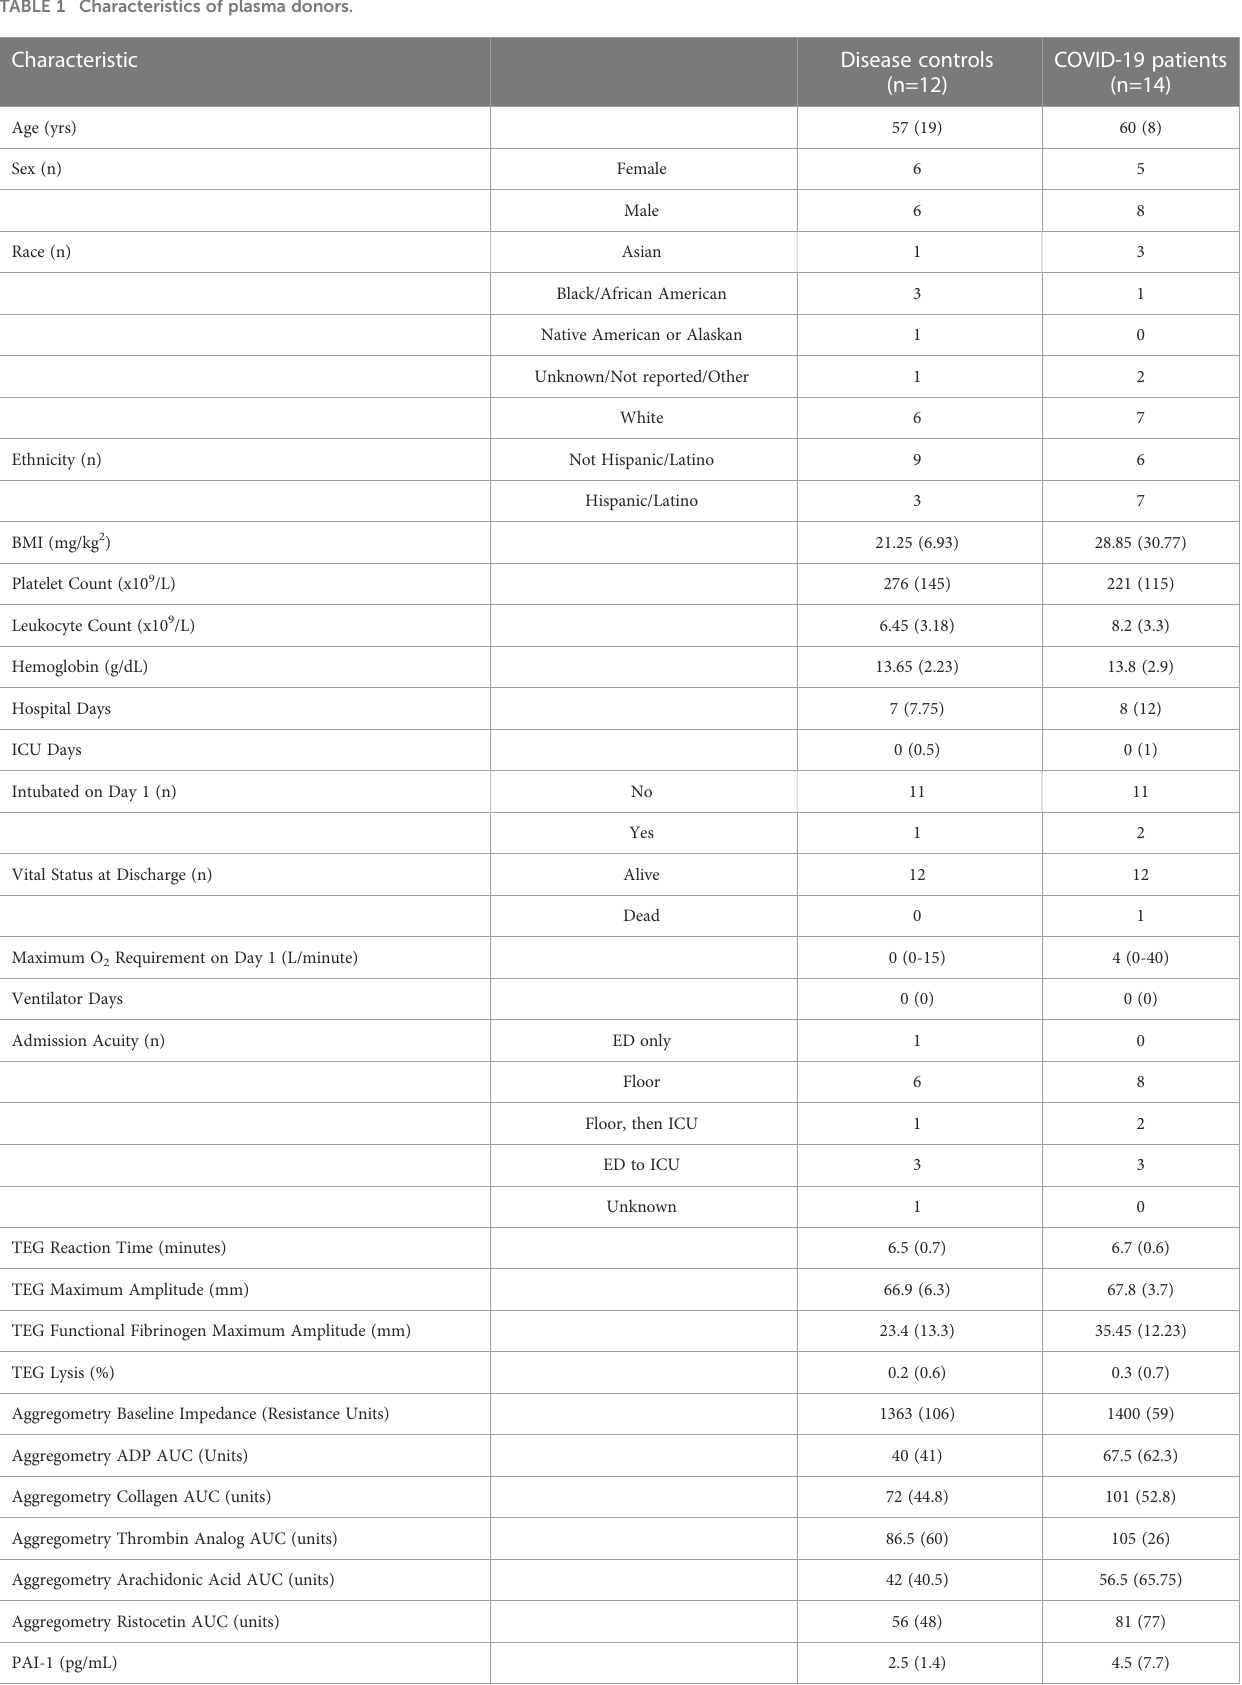
TABLE 1 Characteristics of plasma